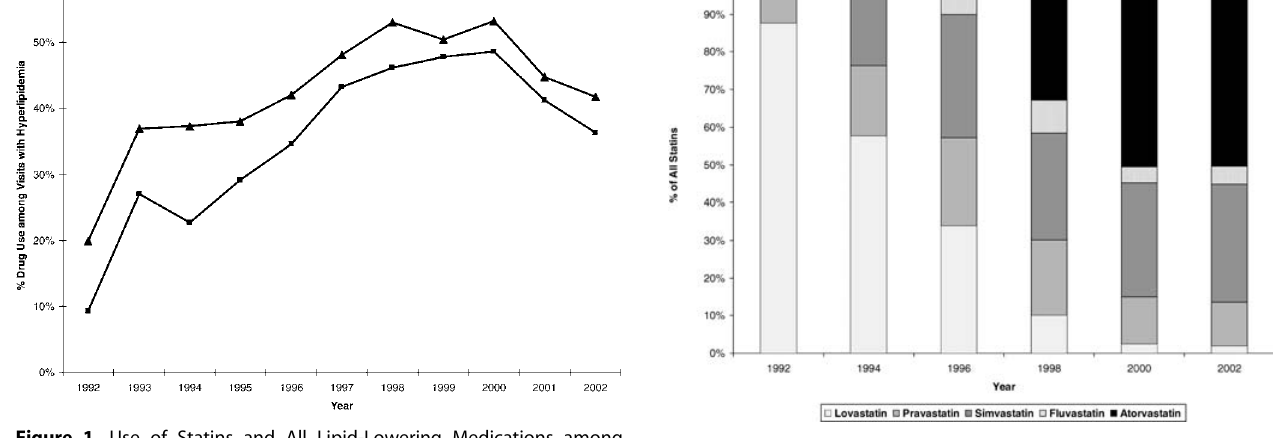
Figure 2. Share of Total Statin Use among United States Ambulatory Visits by Individual Statin